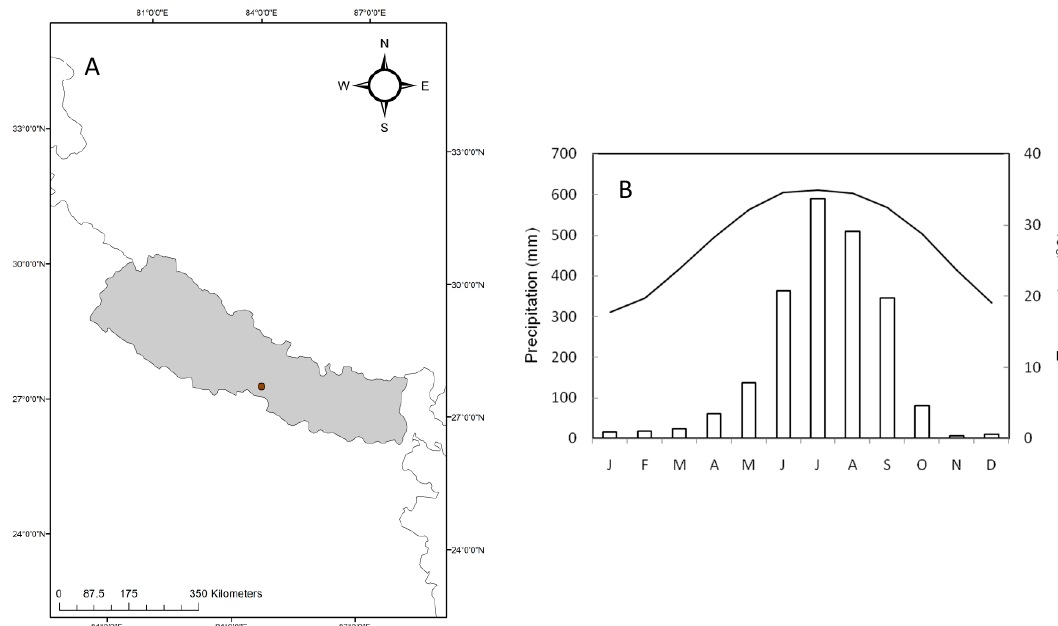
Figure 1. The map of Nepal showing the study area in circle ( A ); Climate diagram of the study area ( B ); Vertical bars indicate precipitation and solid line indicates mean temperature. Average data for the period of 1950 to 2000. The map was created using the ArcGIS software (version 10.3, URL: http: // www.esri.com / software / arcgis /